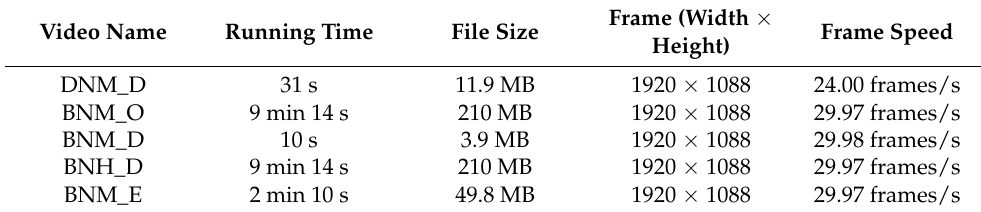
Table 7. Videos in suspect’s smart phone (scenario